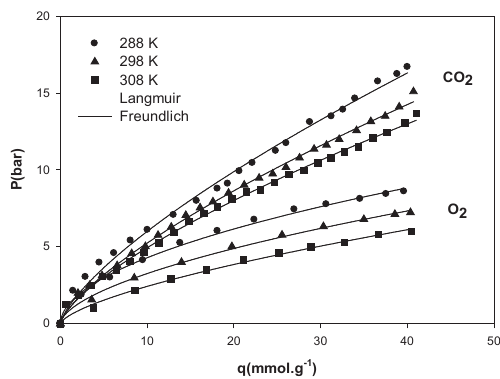
Fig. 7 CO 2 and O 2 adsorption isotherm for MWCNT at different temperatures and nonlinear fit of experimental data with Langmuir and Freundlich models.